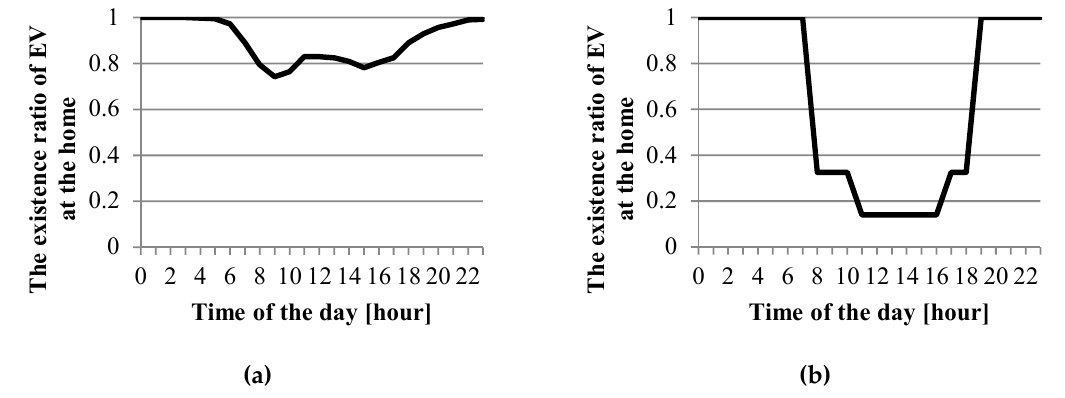
Figure 3. Existence ratio of EVs at home ( a ) non-commuter EV, and ( b ) commuter EV.